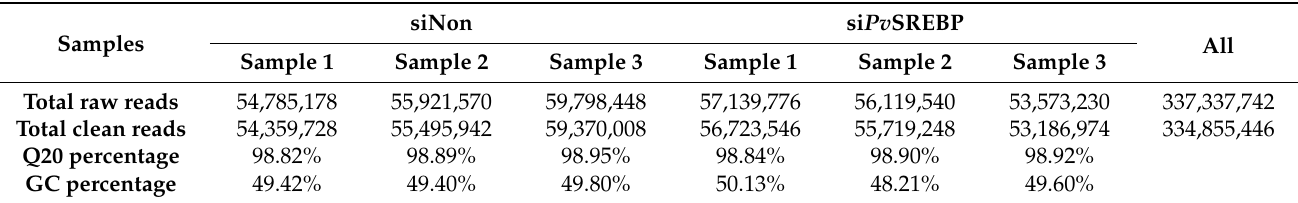
Table 2. Summary of RNA-seq data for P. vannamei injected with siNon or siPvSREBP.